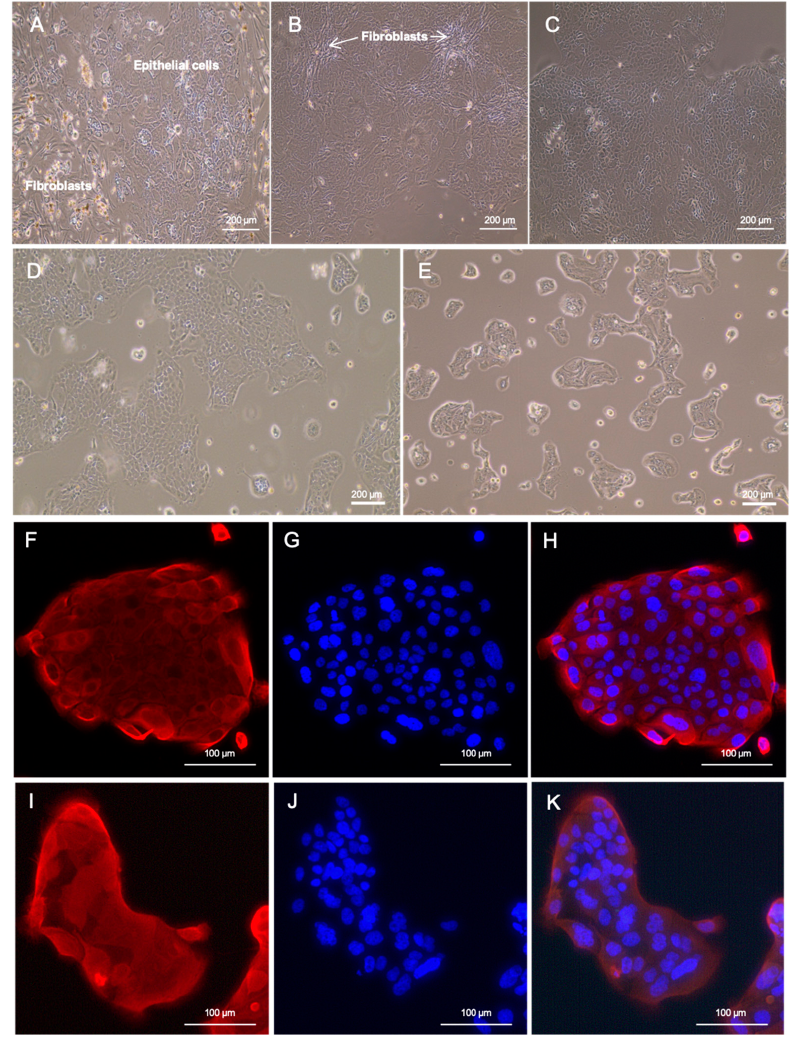
Figure 1. Morphology and immunofluorescent staining for CK7 in the patient-derived cell lines, LuPanc-1 and LuPanc-2. ( A ) LuPanc-1 cells 7 d after cell isolation. ( B ) LuPanc-1 cells after 30 d in culture and partial depletion of fibroblasts. ( C ) LuPanc-1 cells after total fibroblast depletion. ( D ) LuPanc-1 and ( E ) LuPanc-2 cells without fibroblasts. ( F – K ) Immunofluorescent staining of LuPanc- 1 ( F – H ) and LuPanc-2 ( I – K ) cells for CK7 ( F , I ), DAPI ( G , J ), and overlay of CK7 and DAPI ( H , K ).